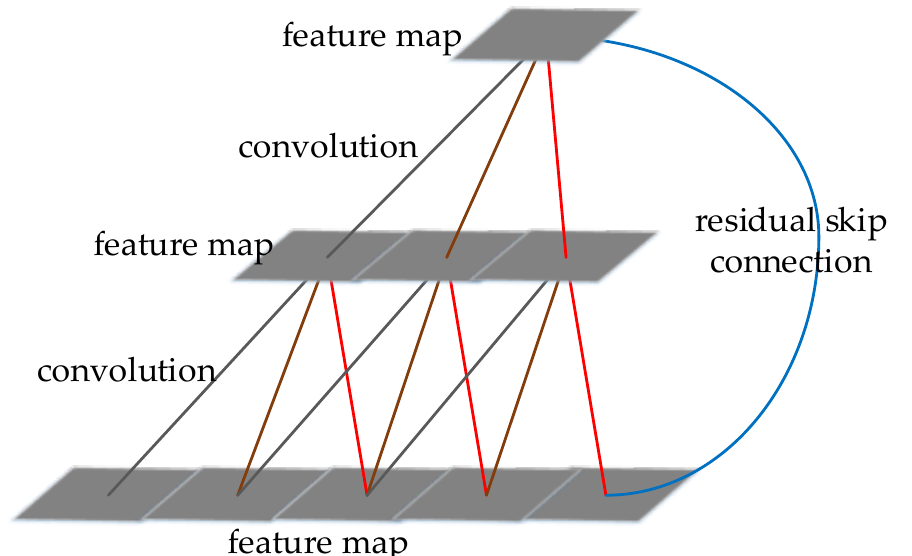
Figure 22. The structure of TCN. Every 3 adjacent feature maps are convolved to the next feature map. The blue connection is a residual skip connection.